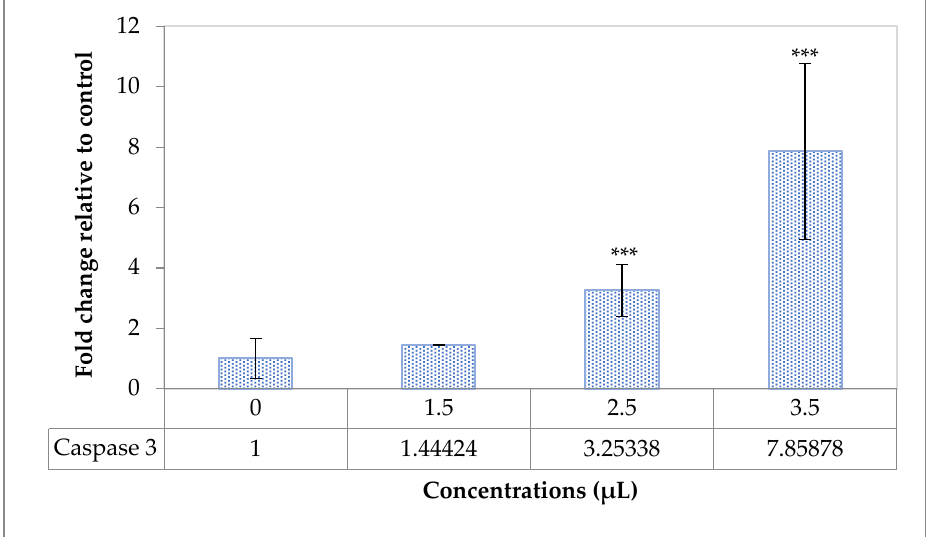
Figure 4. The expression of caspase-3 gene in human breast cancer cell line (MDA-MB231) with different concentrations of Heracleum persicum oil nanoemulsion (HAE-NE), indicating the HAE-NE can induce apoptosis death in breast cancer cell line. Symbols provided on bars indicate differences between groups—***: p < 0.001.